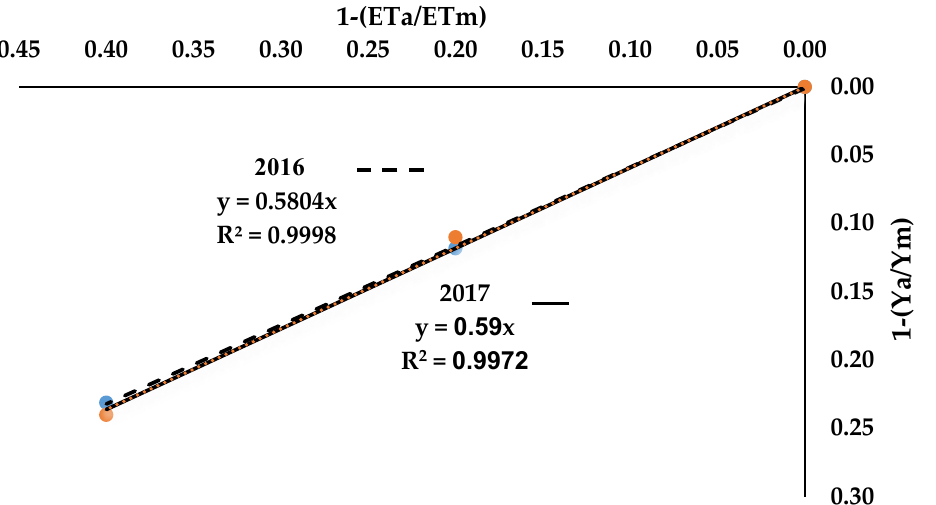
Figure 2. Yield response factor of potato yield under irrigation treatments during 2016 and 2017.